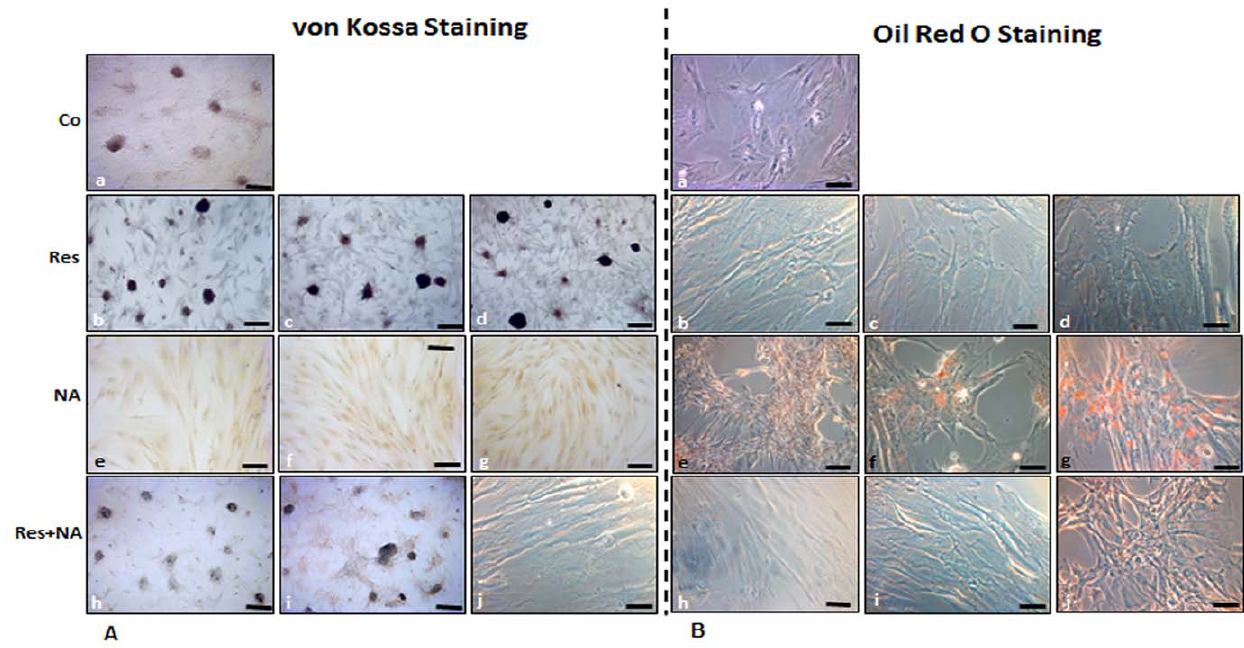
Figure 1. Light microscopic evaluation of the effects of resveratrol and/or nicotinamide on osteoblastic differentiation of MSCs in monolayer culture. a–d: Light microscopic demonstration of osteoid-tissue formation with von Kossa staining (A) or adipose-tissue formation with Oil Red O staining (B). 21 days in monolayer culture. In cultures were stimulated with osteogenic induction medium (A,B: a) and with various concentrations of resveratrol (0.1 m M (A,B: b), 1 m M (A,B: c), 10 m M (A,B: d)calcium deposition was observed (A: a–d), but adipogenesis was negative (B: a–d). Light microscopy demonstrated that MSC cultures treated with osteogenic medium and with the sirtuin inhibitor nicotinamide (1 mM (A, B: e), 10 mM (A,B: f) and 100 mM (A,B: g)), did not differentiate to osteoblastic cells (A, e–g), but differentiated into adipocytes (B, e–g), exhibiting cytoplasmic lipid droplet accumulation in the presence of osteogenic induction medium. In another approach, MSCs were pre-treated with 1 m M resveratrol and then co-treated with various concentrations of nicotinamide (1 mM (A,B: h), 10 mM (A,B: i) and 100 mM (A,B: j)) in osteogenic medium. Pre-treatment of MSCs with 1 m M resveratrol and co-treatment with 1 and 10 mM nicotinamide inhibited adipogenic differentiation of MSCs (B: h–i), favoring osteoblastic differentiation (A: h–i). However, co-treatment with 100 mM nicotinamide resulted in adipogenesis (B: j), but not in osteogenesis (A: j). Magnification: 6 200, bar 30 m m.